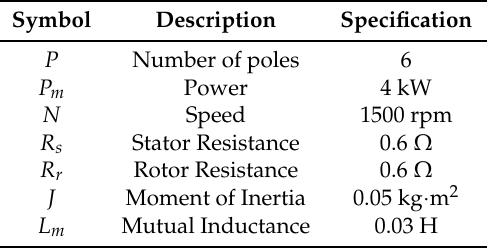
Table 3. Motor Specifications.